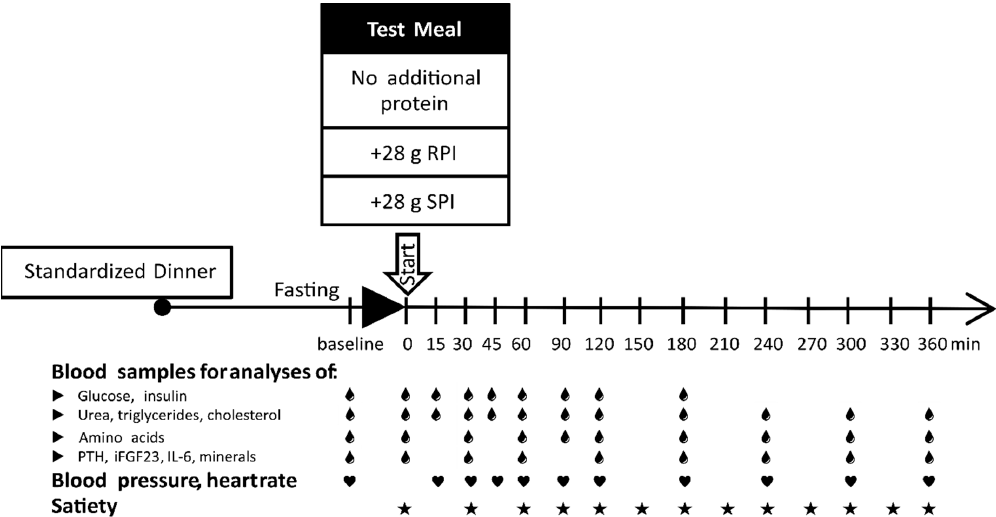
Figure 1. Study schema outlining the dietary interventions and the time points of blood sampling for intended analyses (droplets), blood pressure, and heart rate (hearts) measurements and assessment of satiety (asterisks). Test meals (pasta with tomato sauce and corn oil) were administered without additional protein or with 28 g of either rapeseed protein isolate (RPI) or soy protein isolate (SPI). The meals were served at 8.00 a.m.